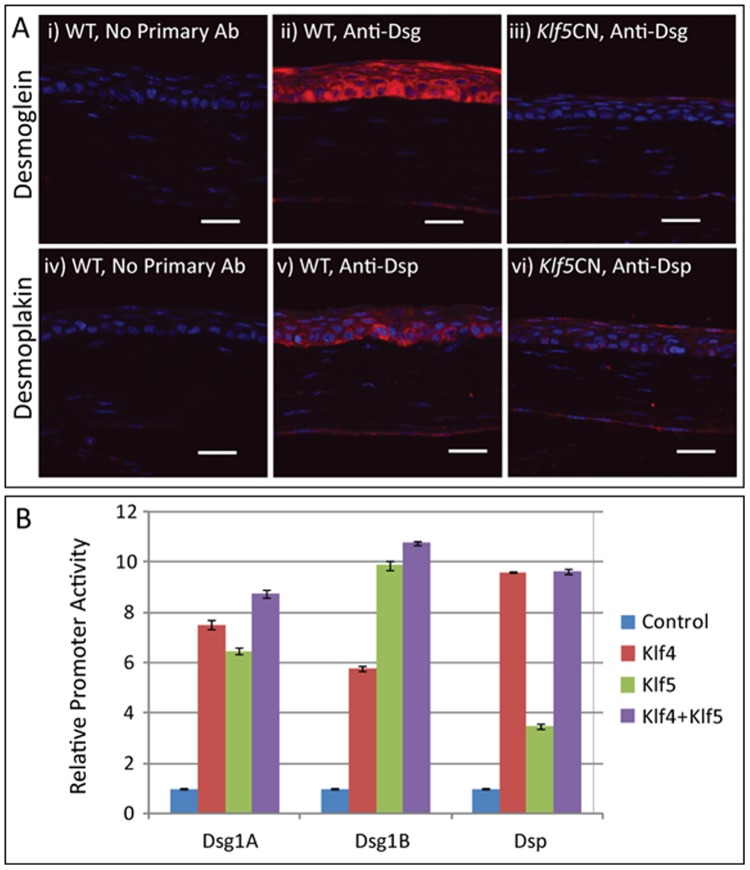
Klf5 contributes to corneal epithelial homeostasis by regulating the expression of desmogleins and desmoplakin.(A) Immunofluorescence shows abundant expression of desmogleins (red, panel ii) and desmoplakin (red, panel v) in the WT but not in the Klf5CN corneal epithelium (panels iii and vi, respectively). Sections processed in a similar manner but without the primary antibody served as negative controls (panels i and iv). Scale bars = 25 µm. (B) Relative activities of 2 kb Dsg1a, Dsg1b and Dsp promoter fragments measured by transient co-transfection assays with or without Klf4, Klf5, or both in NCTC cells. Error bars indicate Standard Error of Mean (SEM). Data are representative of three independent experiments.